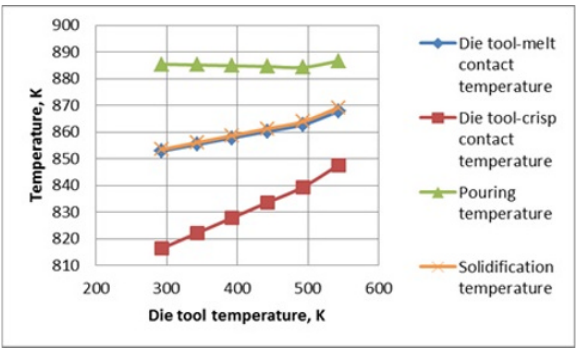
Fig. 4. Dependence of temperature fields on the die